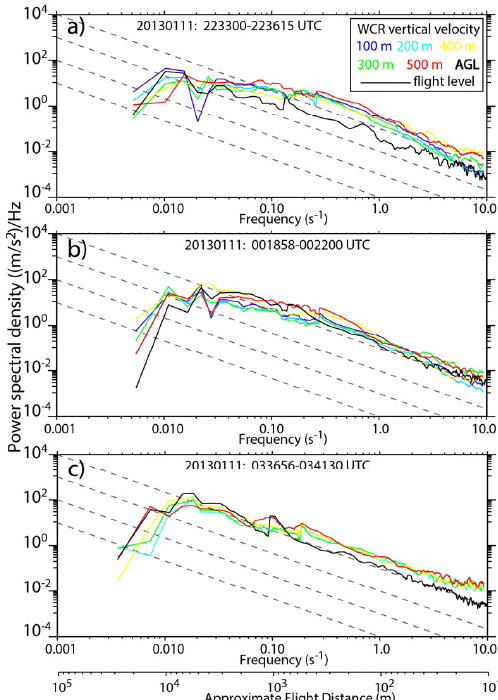
Figure 10. Power spectra of WCR vertical velocity (color lines, representing heights ranging from 100 to 500 m AGL) and flight-level vertical velocity (black line) for along-wind transect ( a ) #1, ( b ) #2, and ( c ) #4. Only the lee-side portion is included, a total distance of ~30 km. Frequency is converted to distance using the average ground-relative speed of the aircraft. The dashed lines show the –5/3 inertial subrange slope at increasing levels of TKE.